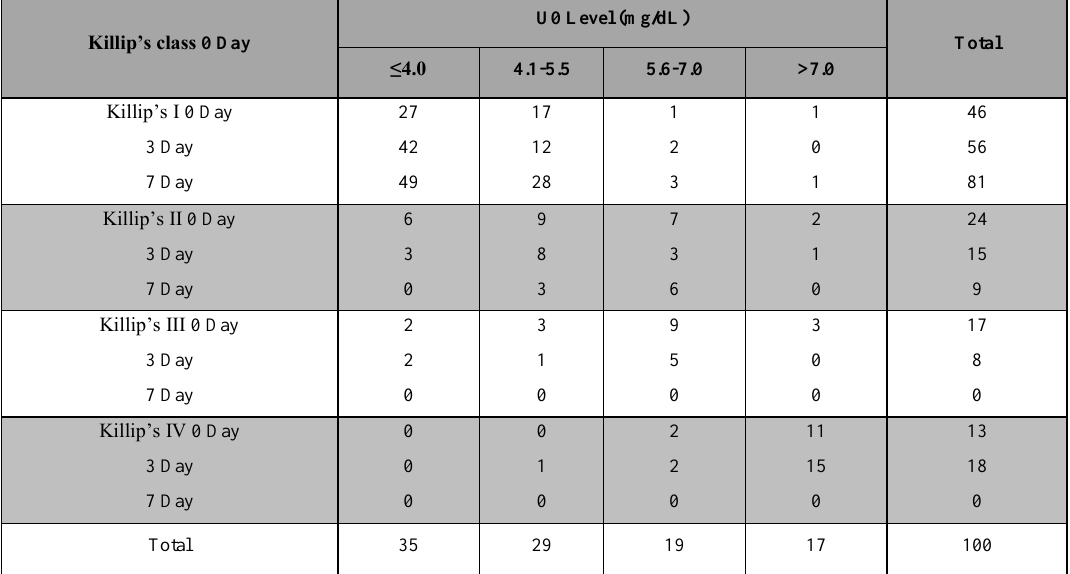
Table 5. Comparison of uric acid level among different Killip’s class on 0, 3 and 7